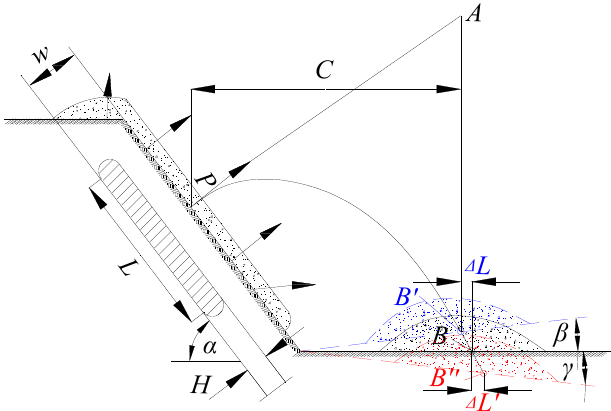
Figure 7. Projectile motion diagram.